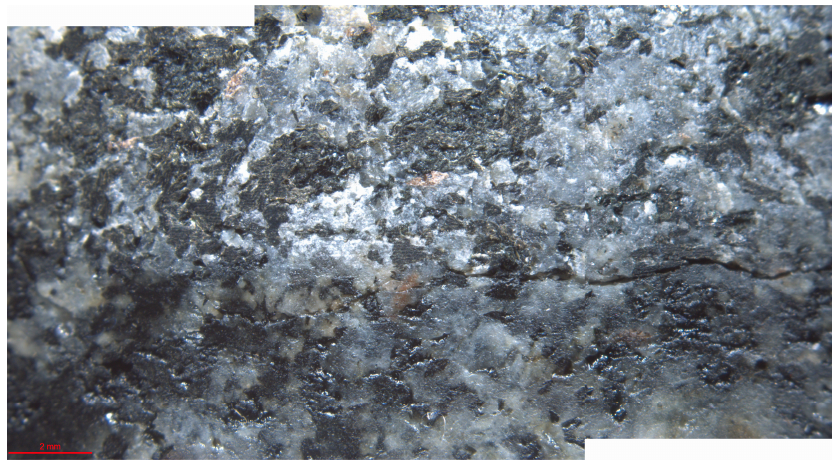
Figure 9. Detailed hydraulic fracture in fractured granite core made using microscope.